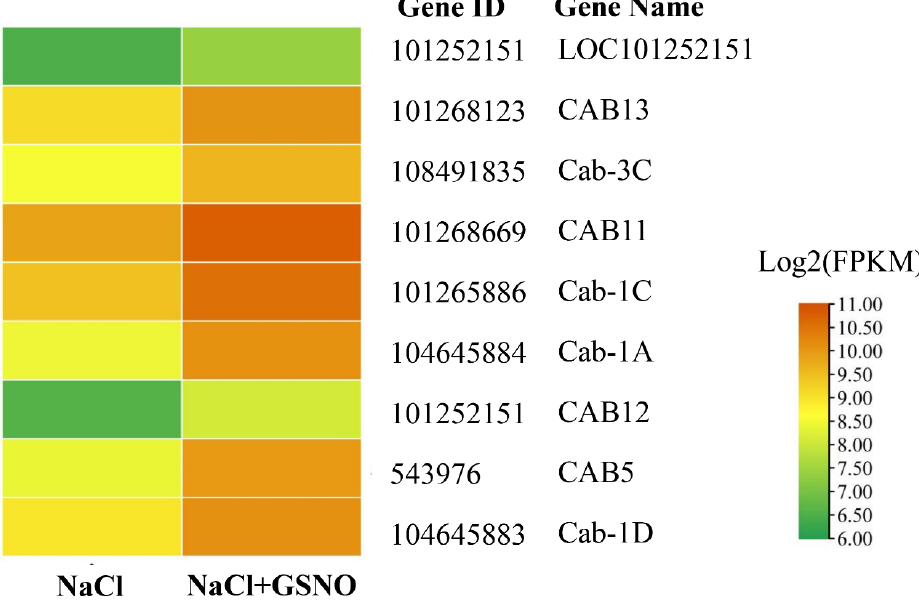
Figure 5. Expression patterns of differentially expressed genes related to photosynthesis in NO alleviation of salt stress. The color scale corresponds to log 2-transformed (fragments per kilobyte per million reads) FPKM values, with red indicating upregulation and green indicating downregulation. Each row represents a unigene. NaCl and NaCl + GSNO represent different treatments. To verify the expression of DEGs, four photosynthesis-related genes were selected. As shown in Figure 6, the expression levels of CAB13 , Cab-3C , LOC101252151 , and CAB11 were decreased under NaCl stress compared with the control. Meanwhile, the expression of these genes under NaCl + GSNO treatment increased, showing about a one-fold in- crease in comparison with NaCl treatment alone. However, this increase was inhibited by cPTIO under salt stress compared with NaCl + GSNO treatment. In addition, cPTIO treat- ment alone also slightly decreased the expression level of these photosynthesis-related genes, implying that NO probably alleviated salt stress by regulating photosynthesis.